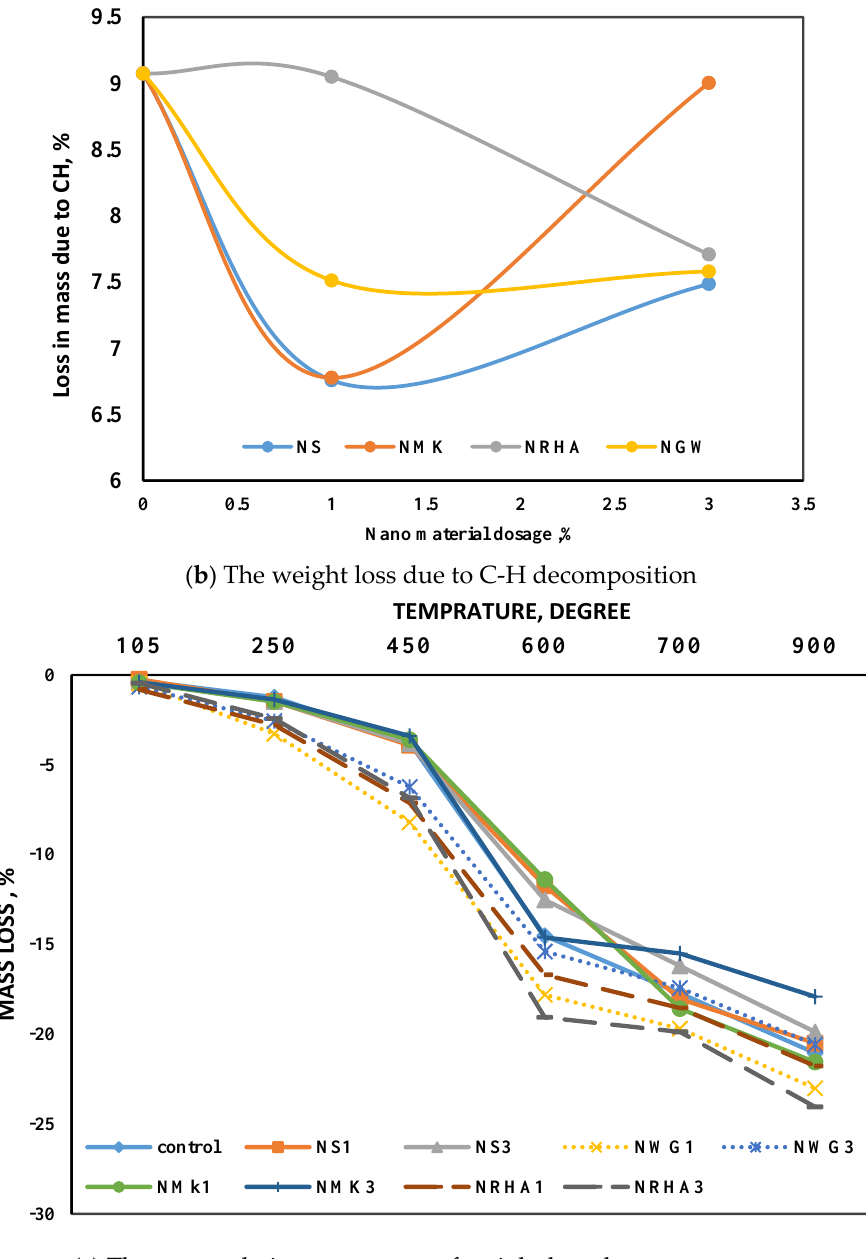
Figure 10. TGA for UHPC mix.